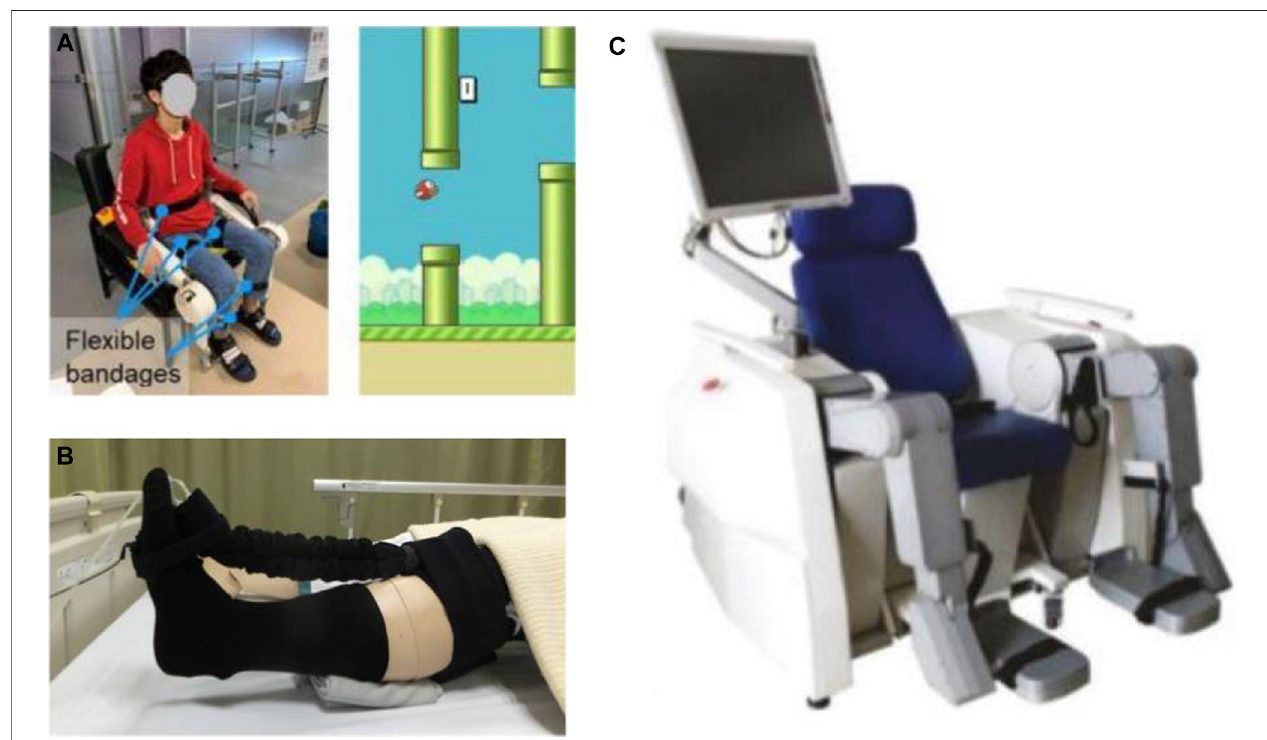
FIGURE 4| Roboticdevicesfor sitting/lying home-based lower-limb rehabilitation: (A) EMG-Controlled Knee Exoskeleton (Lyu et al., 2019), (B) Soft Robotic Sock (Low et al., 2019), and (C) LLR-Ro (Feng et al., 2017).